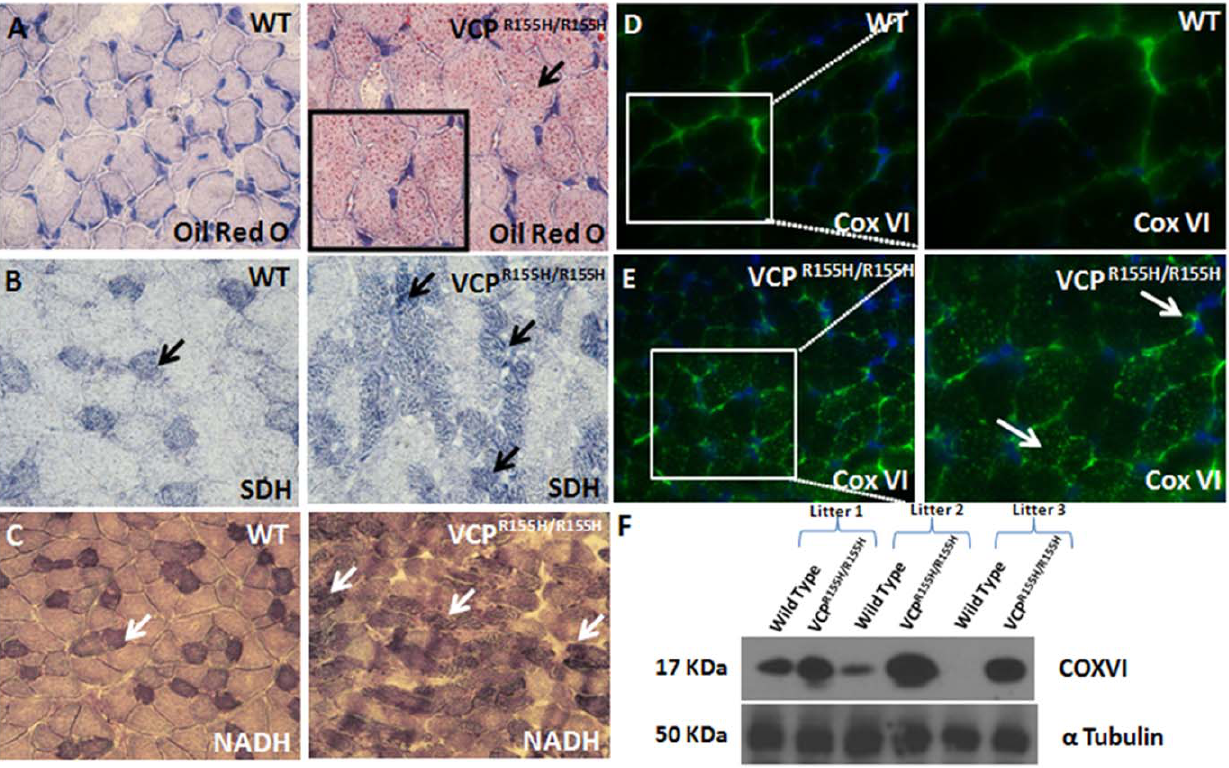
Figure 3. Immunohistochemical analysis of mitochondrial markers in VCP R155H/R155H and WT quadriceps. (A) Oil Red O staining of WT and VCP R155H/R155H mice quadriceps reveals increased lipid composition (as shown in inset) (Mag 63 6 ). (B) Staining with SDH enzyme complex revealed deep-purple regions in Type 1 fibers, reflective of increased oxidative potential in these fibers and a scattered purple-speckled appearance in Type 2 fibers in the VCP R155H/R155H and (C) increased NADH (reduced form production) in the VCP R155H/R155H as compared to their WT controls (‘‘checkered’’ pattern) (Mag 63 6 ). Immunohistochemical analyses of COX-IV in (D) WT and (E) VCP R155H/R155H mice. (F) Western blot analyses of COX-IV protein expression levels in the WT and VCP R155H/R155H mice. Alpha tubulin was used as a loading